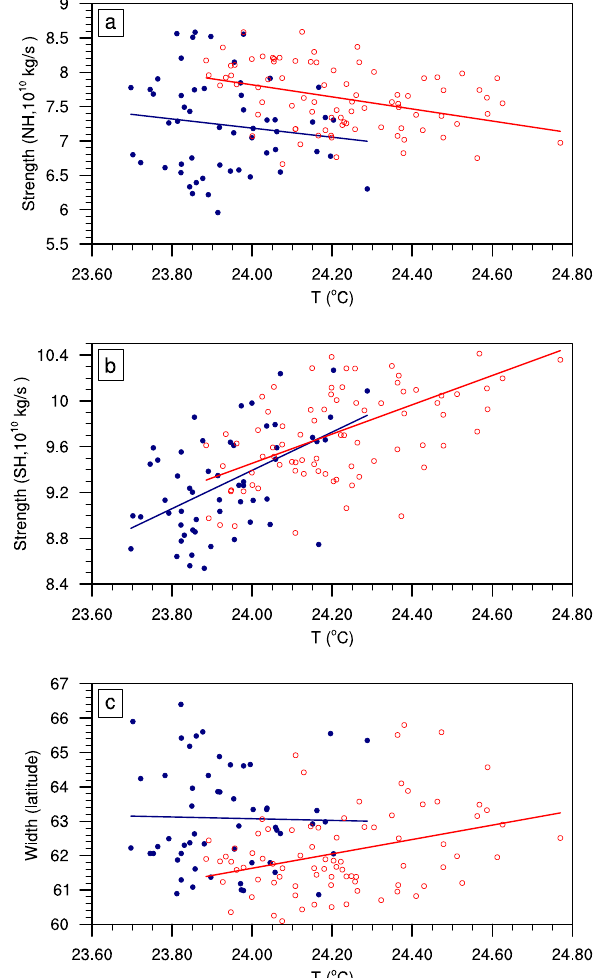
Fig. 6. Scatter plots of the strength and width of the Hadley Cir- culation versus the averaged 20CR2 surface air temperature in the tropics and subtropics (30 ◦ S–30 ◦ N) during the cold (1871–1925, blue) and warm (1926–2008, red) periods: (a) the strength of the northern component, (b) the strength of the southern component, and (c) the